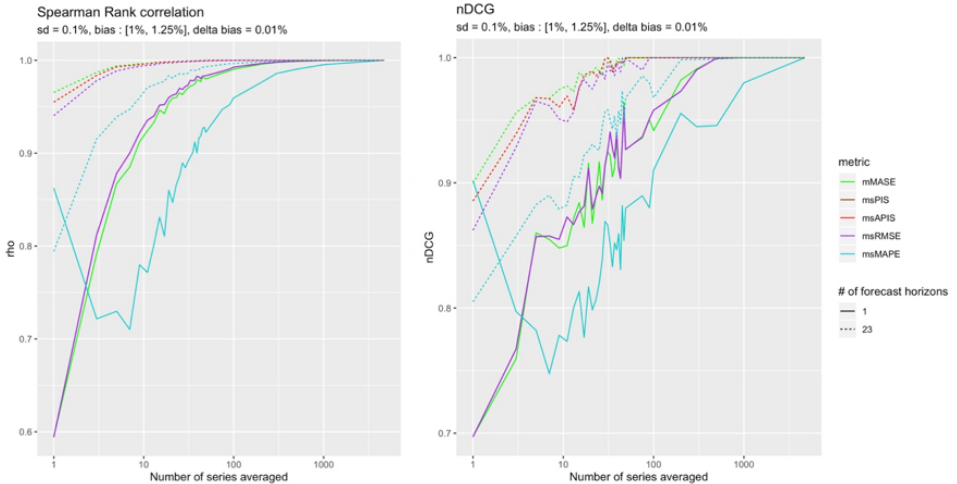
Figure 19. Spearman Rank correlation and nDCG for ( − + − )